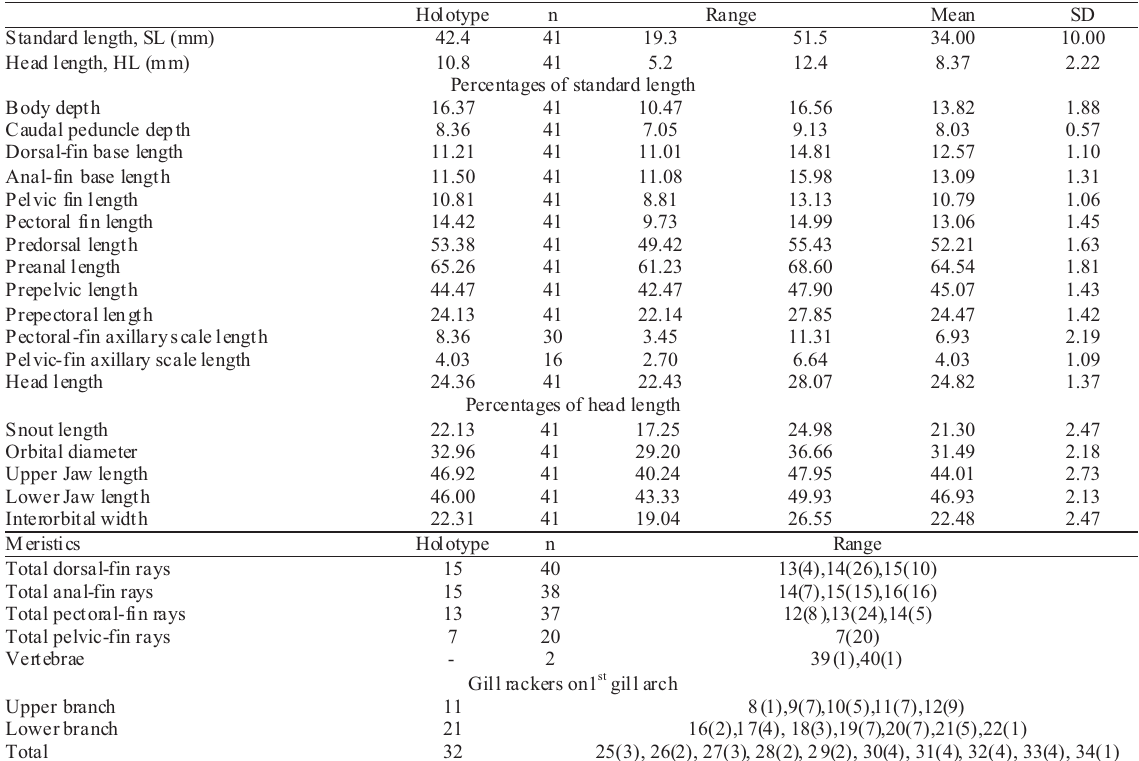
Table 1. Morphometrics and meristics of Anchoviella juruasanga . n = number of examined specimens, SD = Standard Deviation (frequency in parenthesis)